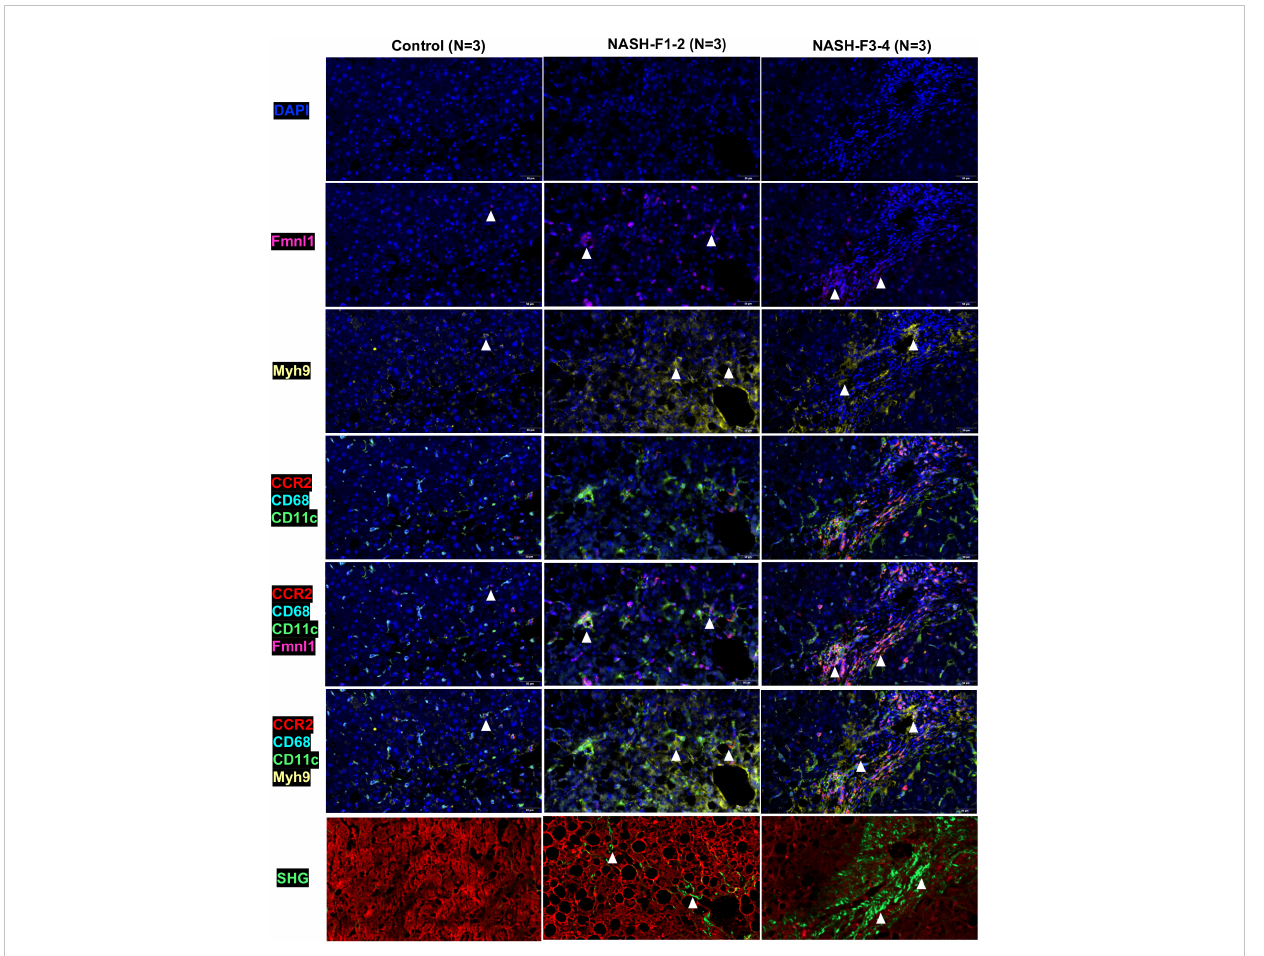
FIGURE 6 Fmnl1 and Myh9 expression in MMD system cells and collagen deposition in livers from healthy controls and NASH patients with fi brosis. ps: MMD: monocyte-macrophage-DC (MMD); F1-2: Fibrosis stage 1-2, F3-4: Fibrosis stage 3-4. DAPI: cell nucleus, Fmnl1: Fmnl1+ cells (white arrow), Myh9: Myh9+cells (white arrow); CCR2/CD68/CD11c/Fmnl1: Fmnl1 expression in MMD system cells (white arrow); CCR2/CD68/CD11c/Myh9: Myh9 expression in MMD system cells (white arrow); SHG, collagen detected by second harmonic